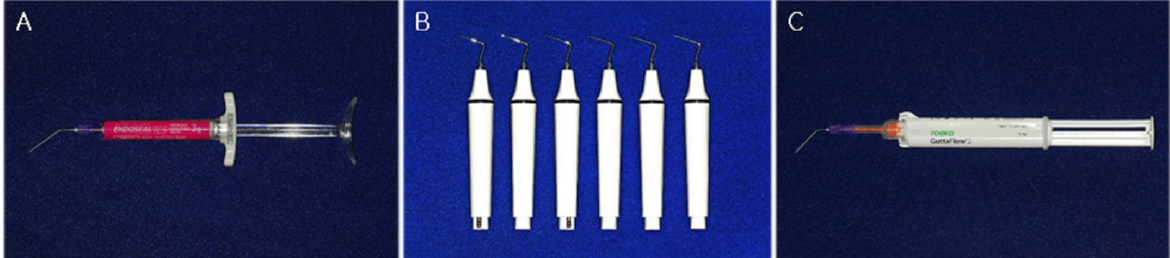
Figure 2. Representative images of each group from standard radiographs, micro-CT scans, and light microscopes. ( A1 – A5 ) SE group, ( B1 – B5 ) VE group, ( C1 – C5 ) VG group. Representative pre-operative standard radiographic images of each group (A1, B1, and C1). The specimens were filled using GP as follows: (A2) single-cone technique + En- doseal TCS, (B2) VibraTHO technique + Endoseal TCS, (C2) VibraTHO technique + Gut- taFlow 2. Micro-CT scans of the cross-section of root canals at the apical (A3, B3, and C3) and middle thirds (A4, B4, and C4). Microscopic images of the sectioned root surface at the middle thirds (A5, B5, and C5), where the micro-CT cross-sectional images (A4, B4, and C4) were obtained. CT: computed tomography, GP: gutta-percha, VibraTHO: ultrasonic vibration and thermo-hydrodynamic obturation. 2.3. Micro-CT